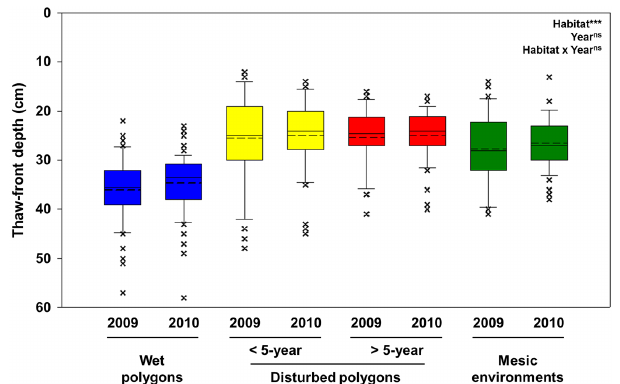
Figure 4. Thaw-front depth monitored in July 2009 and 2010 in the four habitat types studied in the Qarlikturvik valley, Bylot Is- land, Nunavut. The 10th percentile, lower quartile, median (solid line), mean (dashed line), upper quartile and 90th percentile are shown. See Table A1 for sample sizes and post-hoc contrasts. ∗∗∗ P <0.001, ns: statistically non-significant effect.